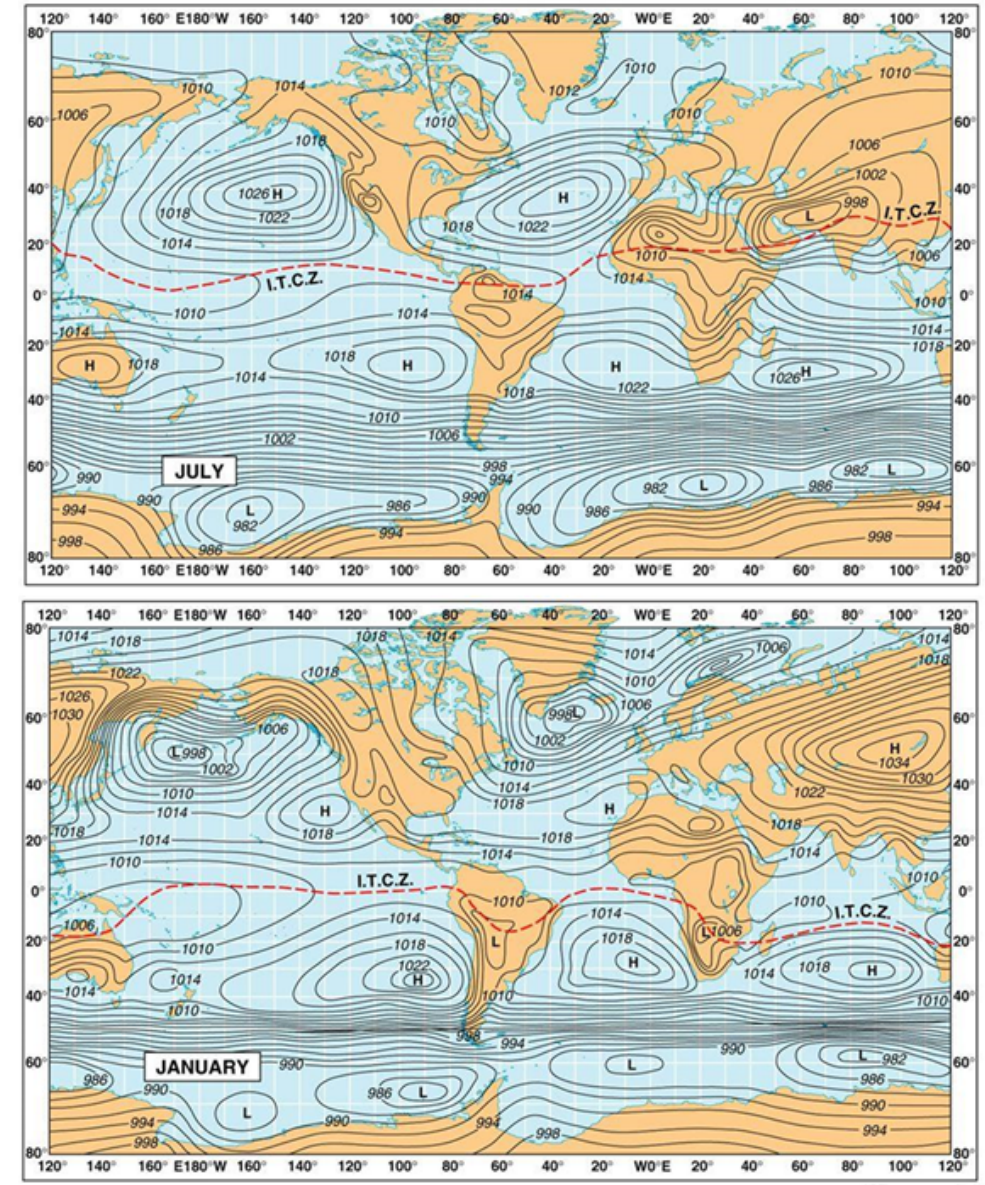
Figure 10. Global pressure and surface wind for July and January